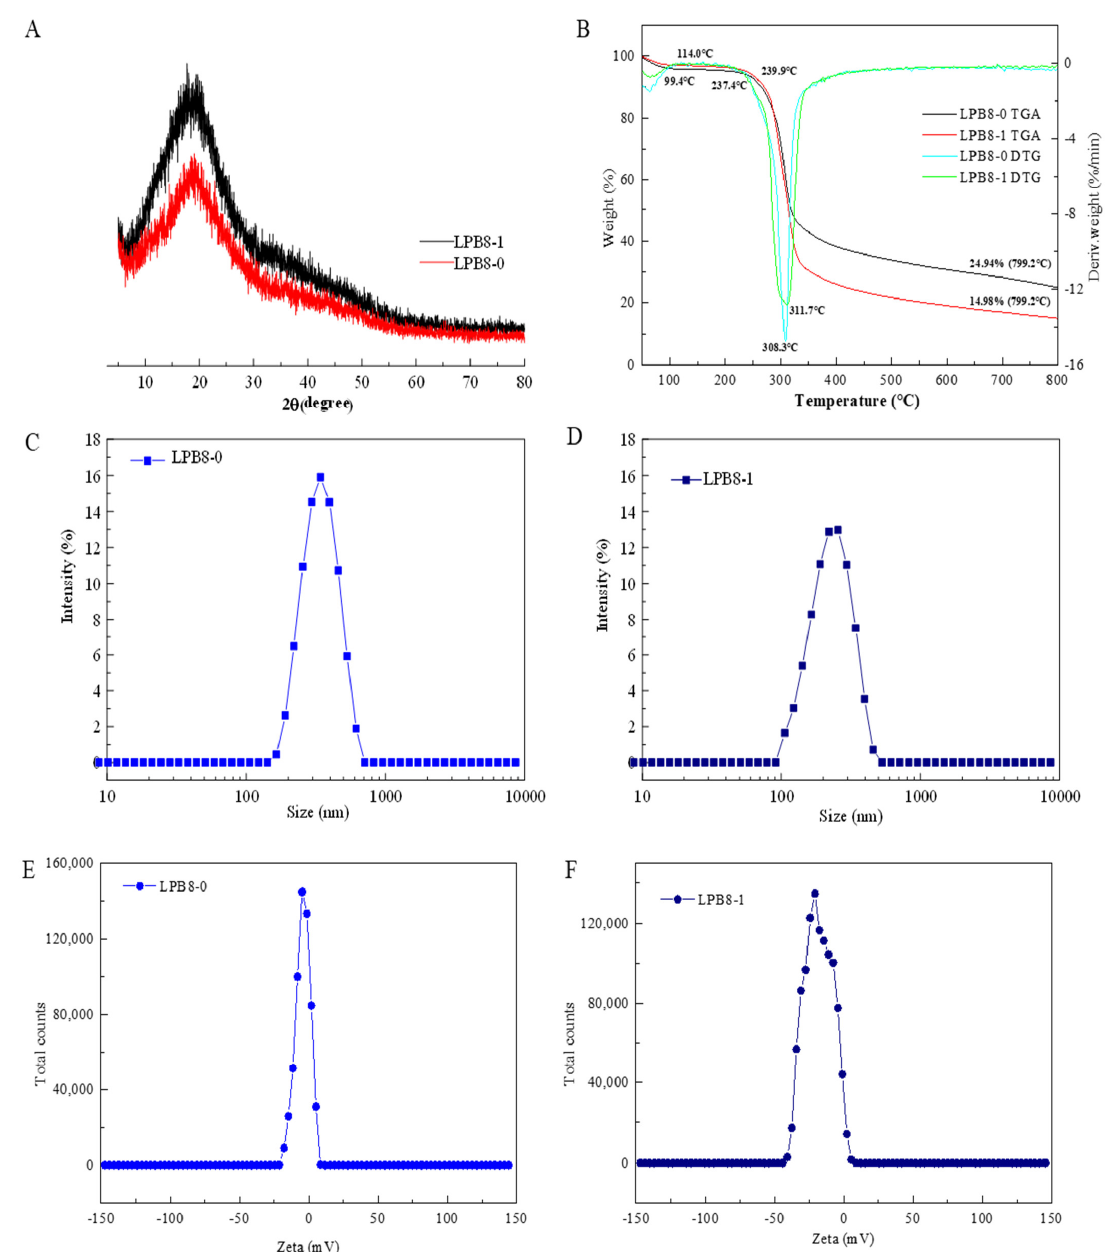
Figure 4. The XRD ( A ) and TGA ( B ) spectra of LPB8-0 and LPB8-1; the zeta potential ( C , D ) and particle size ( E , F ) at various concentrations of LPB8-0 and LPB8-1.